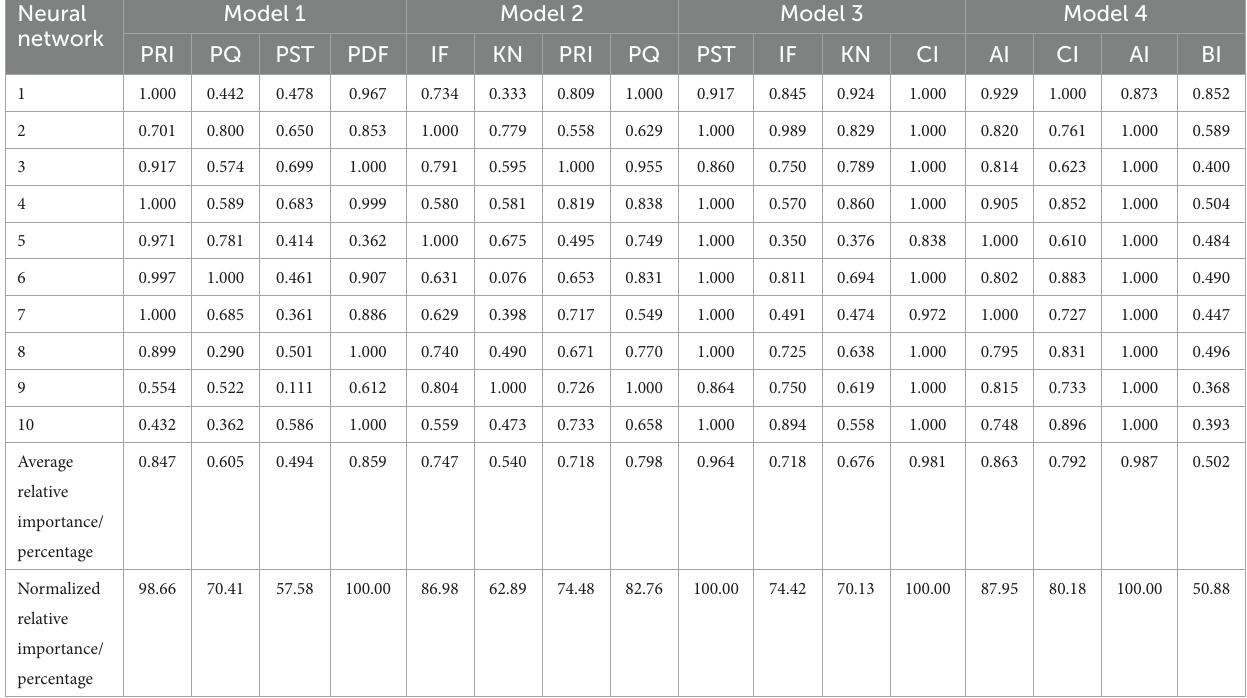
TABLE 9 Sensitivity analysis of neural networks. Neural